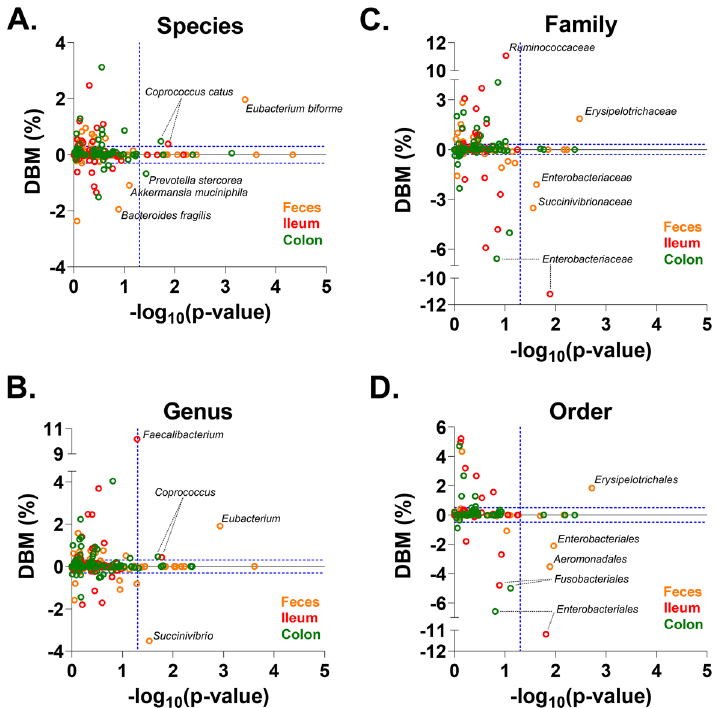
Figure 5. Differences between mean relative abundances (DBM) ( y -axis) for the control group (healthy individuals) vs. SpA patients, for feces (orange), ileum (red) and colon (green) samples. Positive DBM values indicate those taxa overrepresented in healthy individuals, and negative indicate those overrepresented in SpA patients such as Prevotella stercorea in the colon ( A ). In the x -axis, p-values for the White’s non-parametric t-test paired comparisons (healthy vs. SpA) are plotted. The DBM arbitrary thresholds (± 0.2%) and the significant p-value threshold (0.05) are shown in dashed blue horizontal and vertical lines, respectively. Taxa with significant differential abundance for species ( A ), genus ( B ), family ( C ) and order ( D ) classifications are